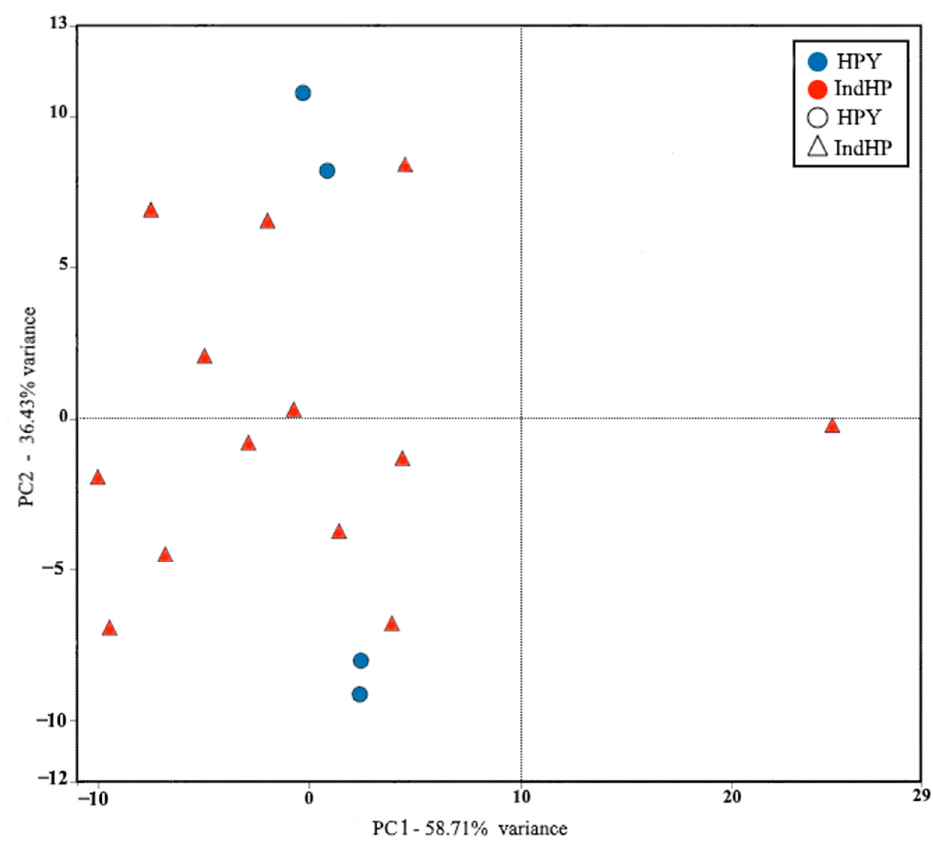
Figure 5. Principal component analysis of the ossicles of the seventeen individuals from Tunisia; the values used are the means calculated from twenty ossicles per individual. Morphometric variables in the PCA: LngT: length of table-shaped ossicles, LngB: length of button-shaped ossicles, LagB: width of button-shaped ossicles. Distribution of the analyzed individuals on the space defined by the first two components of the PCA (blue circle: first haplotype HPY; red triangle: second haplotype IndHP).